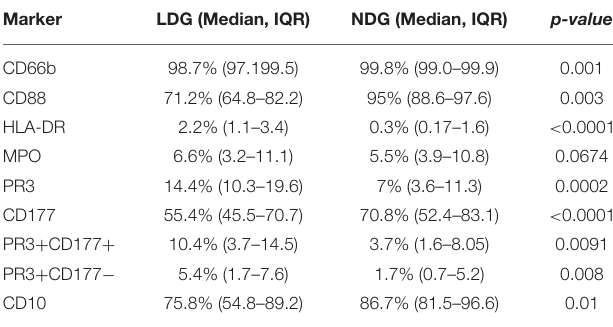
healthy controls compared to NDG fraction (4.9%, IQR 3.0– TABLE 3 | Percentage expression of phenotypic markers on LDG and